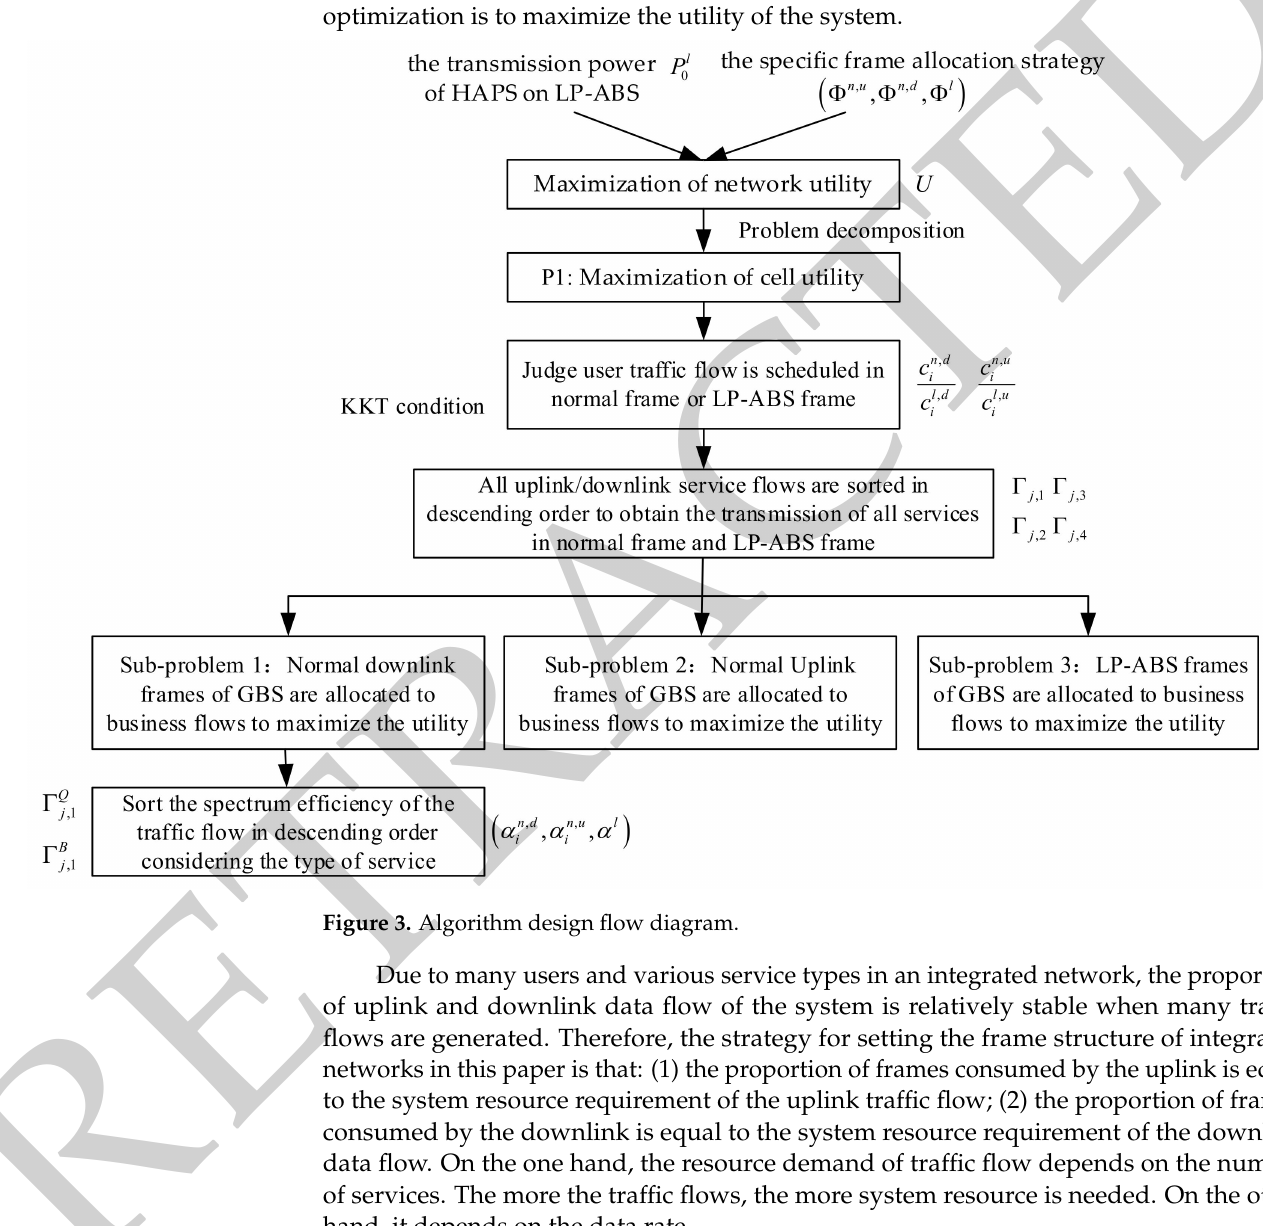
Figure 3. Algorithm design flow